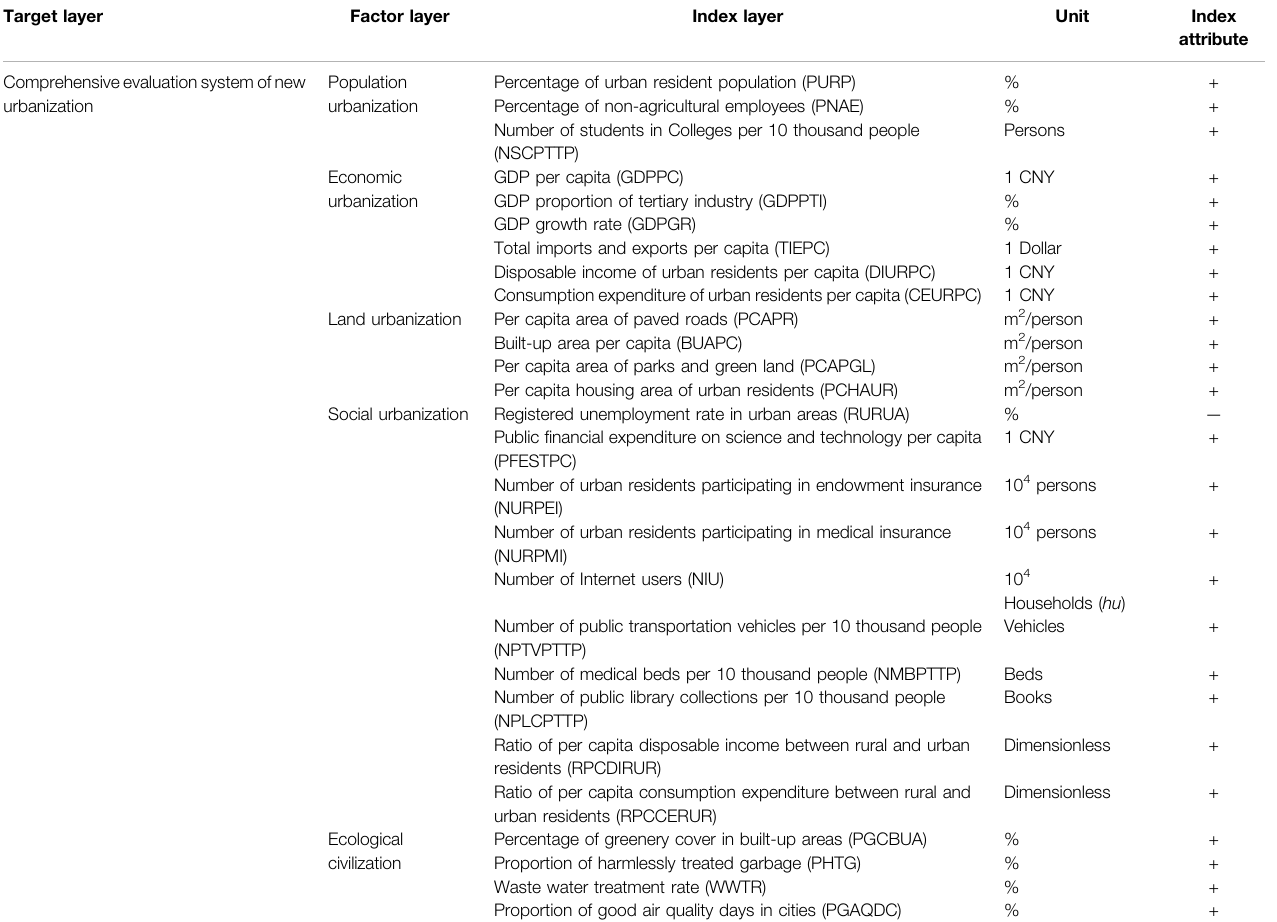
TABLE 1 | Comprehensive evaluation index system of new urbanization level. Target